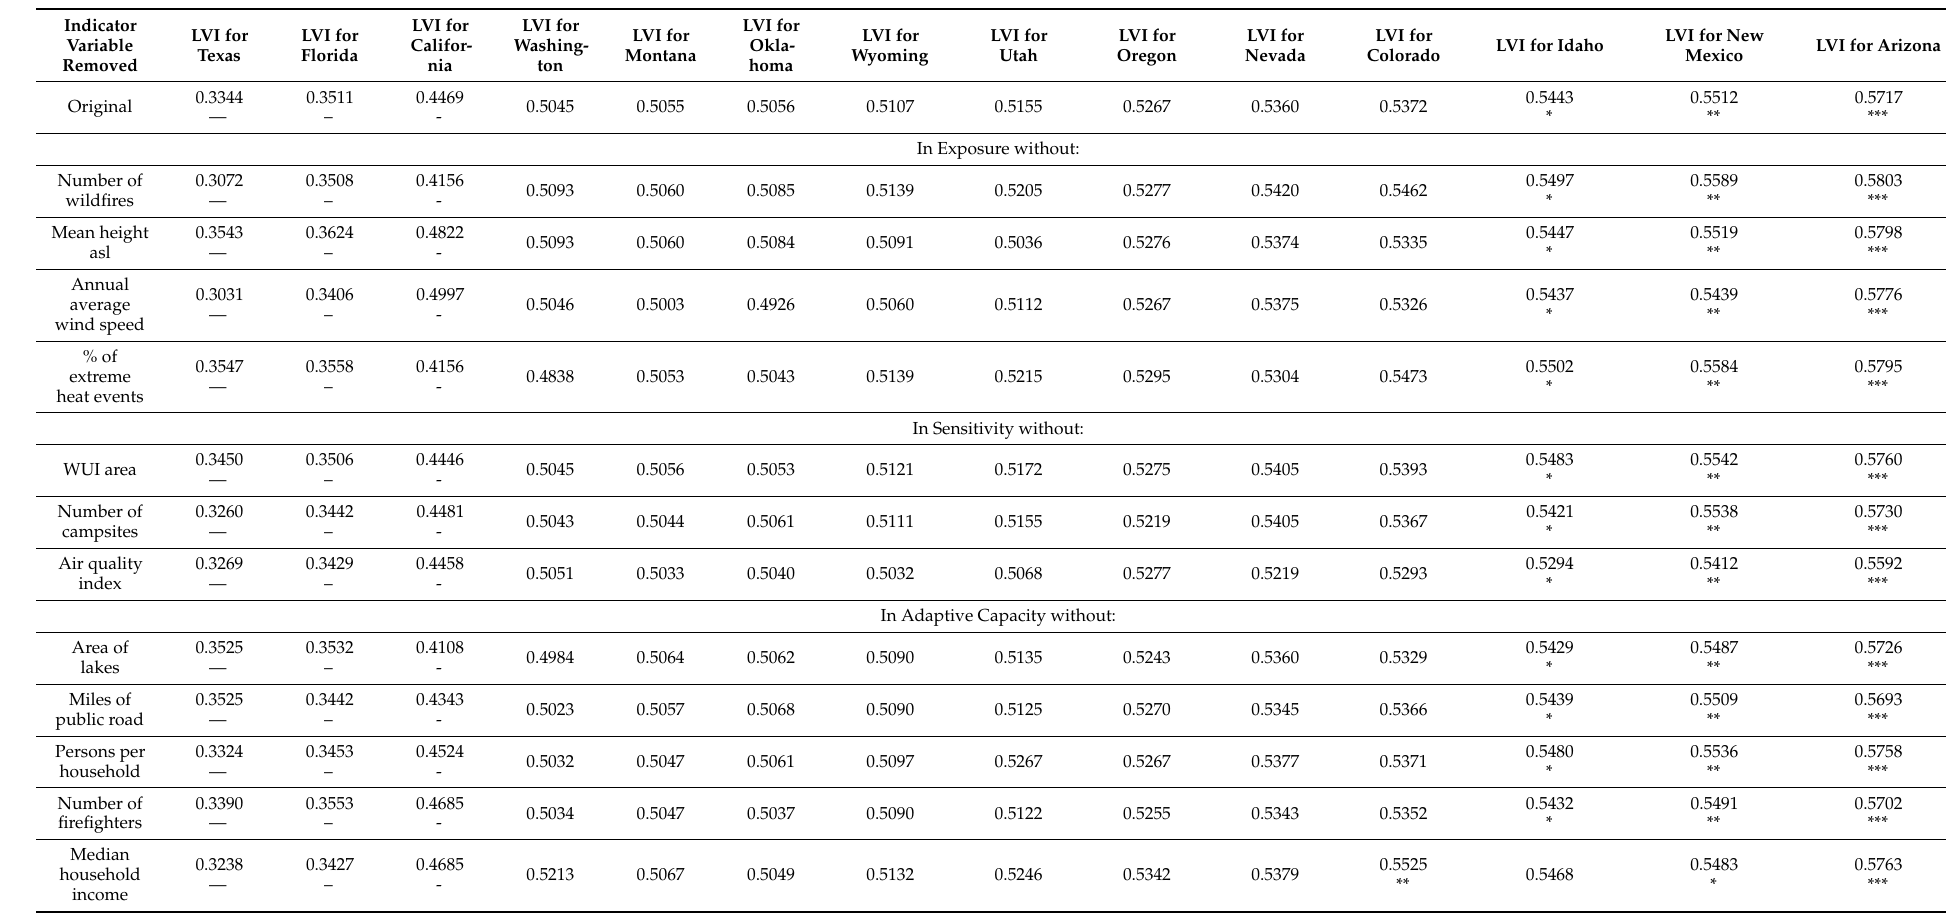
Table A8. This table shows the original LVI value outputs for each state generated from our framework, compared to the LVI scenarios calculated when one indicator variable is omitted from the calculation under a specific major component. The symbols under some LVI represent the lowest three (—, –, -) and highest three (***, **, *) LVI value among the